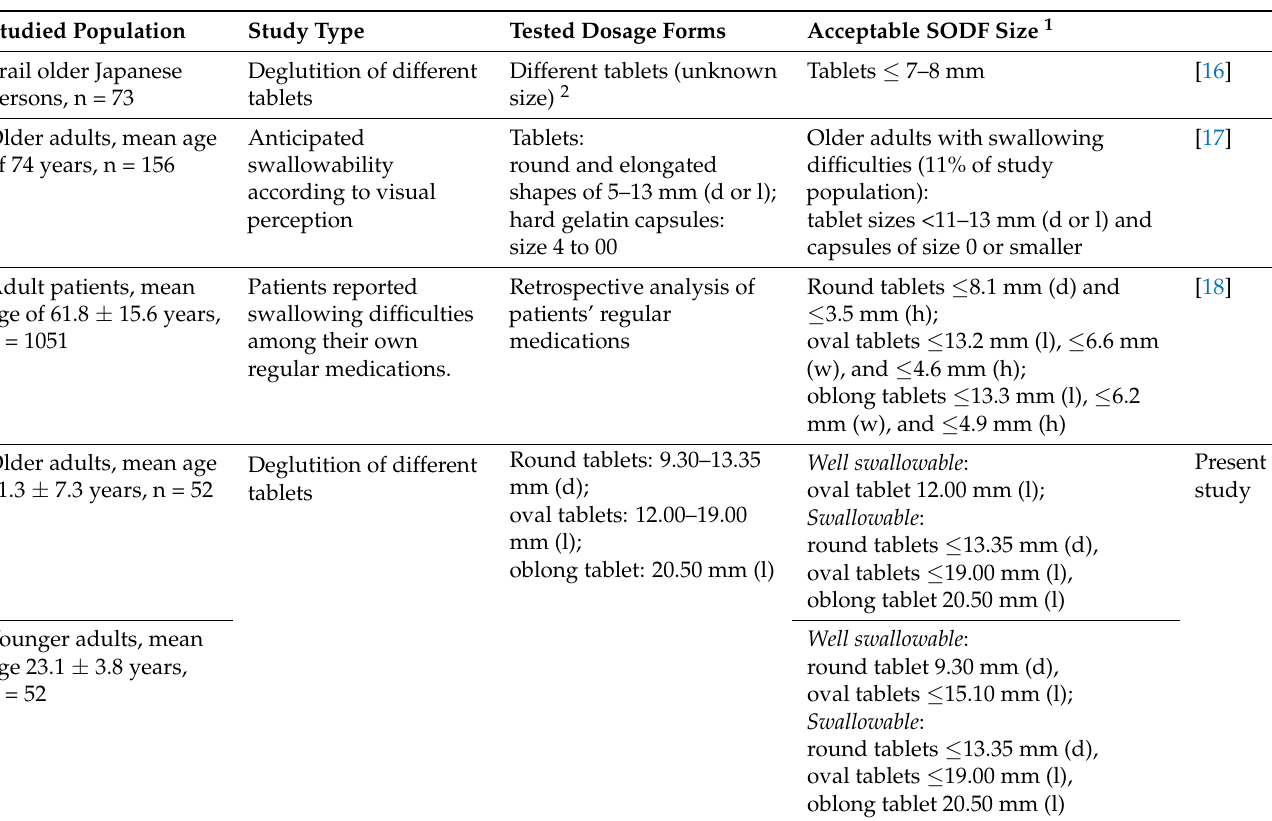
Table 5. Studies focused on tablet sizes and tablet shapes associated with swallowing difficulties in (older)